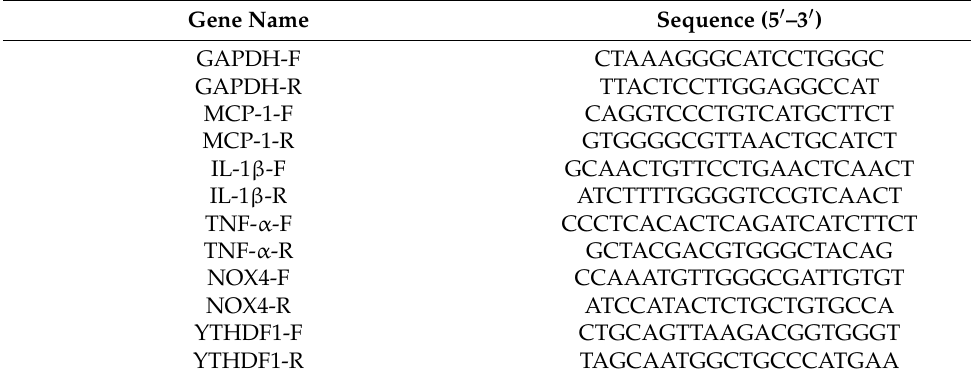
Table 1. List of mouse primers used for